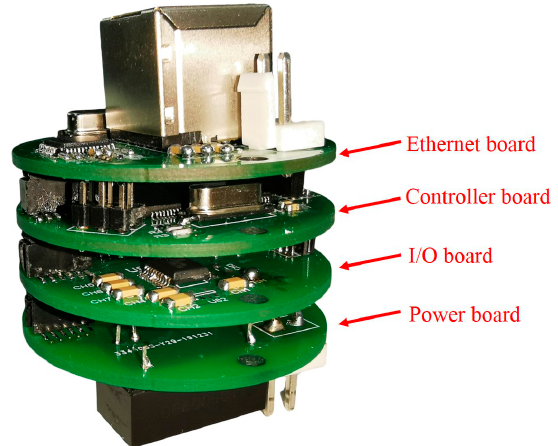
Figure 8. Multi-layer stacked printed circuit boards of the SIA.